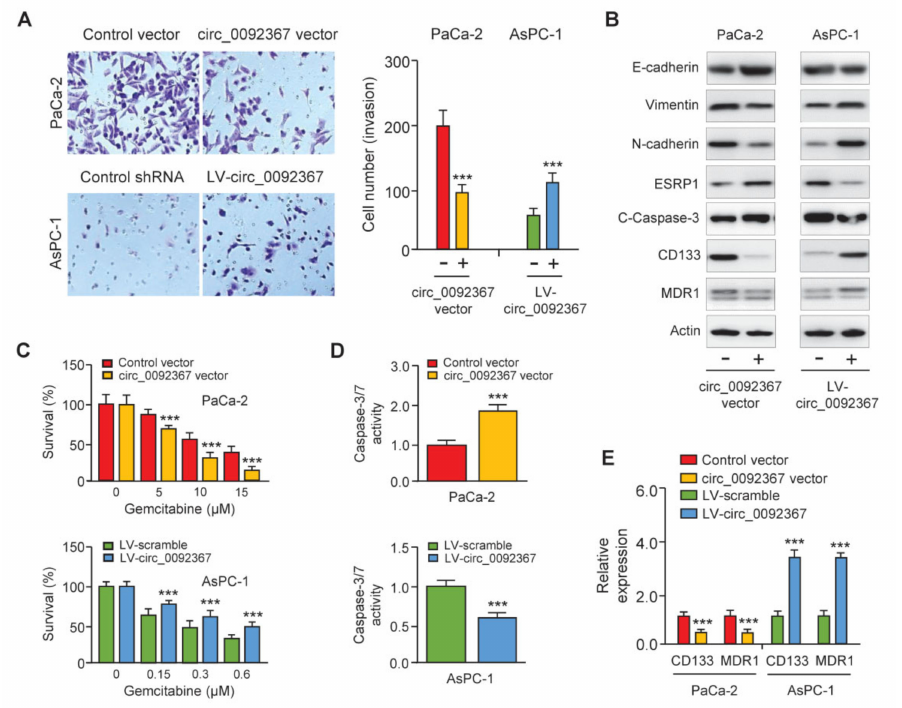
Figure 3. Circ_0092367 Represses Invasion, EMT, and Gemcitabine Resistance in PC Cells. ( A ) Inva- sion assay showed the effects of circ_0092367 on cell invasiveness. ( B ) Western blotting analysis was conducted to explore the expression of EMT-related proteins, cleaved-caspase-3, CD133, and MDR1 in PC cells following overexpression or knockdown of circ_0092367. ( C ) PC cells overexpressing or under-expressing circ_0092367 were treated with gemcitabine for different dilutions as indicated. A comparison of cell viability was performed using CCK-8 assays. ( D ) Effects of circ_0092367 on gemcitabine-induced cell apoptosis were detected using the Caspase-3/7 assay. ( E ) CD133 and MDR1 expressions in PC cells after either overexpression or silencing of circ_0092367 were measured using qRT-PCR analysis. The experiments in ( A , C – E ) were repeated three times independently with similar results. *** p